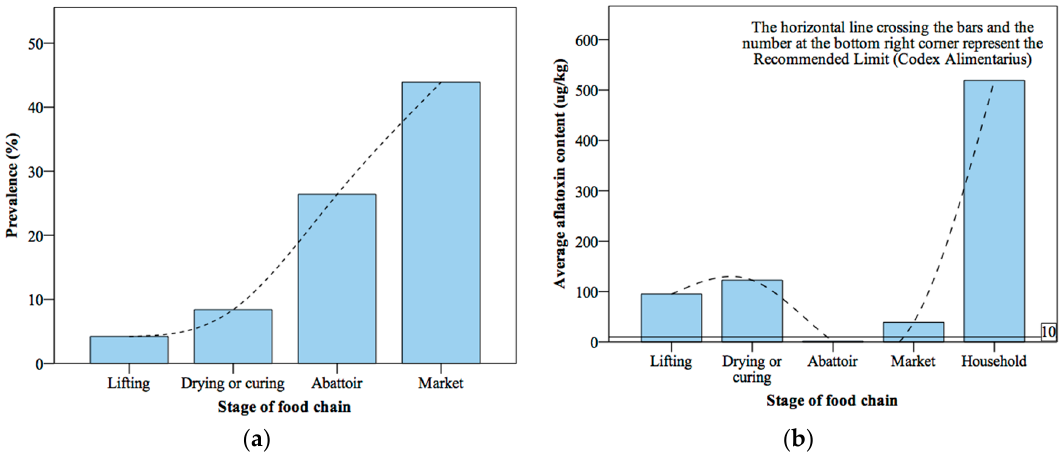
Figure 3. The prevalence ( a ) and level ( b ) of aflatoxin contamination in the major stages of the food production chain. The provisional limit for aflatoxin levels recommended Codex Alimentarius is 10 µg/kg. Based on Casadei [6], Van Rensburg et al. [7], van Wyk et al. [1], Warth et al. [2] and Sineque et al. [8]. These studies were carried from 1985 to 2017 and included in total 934 samples including agricultural crops, chicken livers and gizzards.